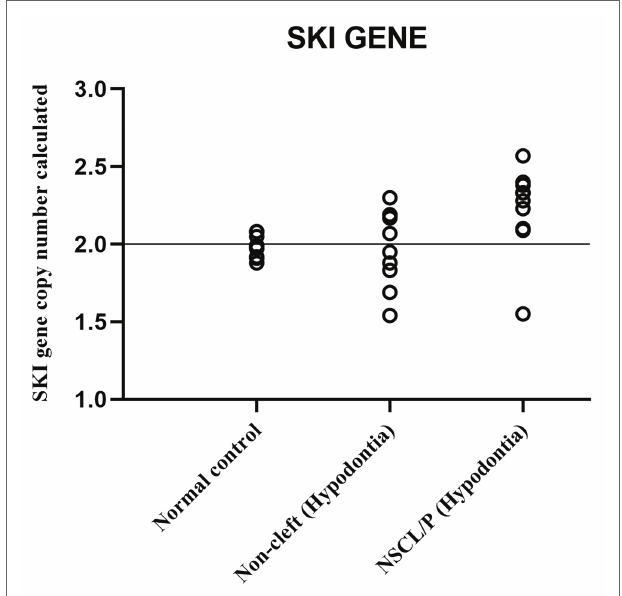
FIGURE 4 | Scatter plot indicated copy number calculated value of SKI among NSCL/P with hypodontia, non-cleft with hypodontia and normal